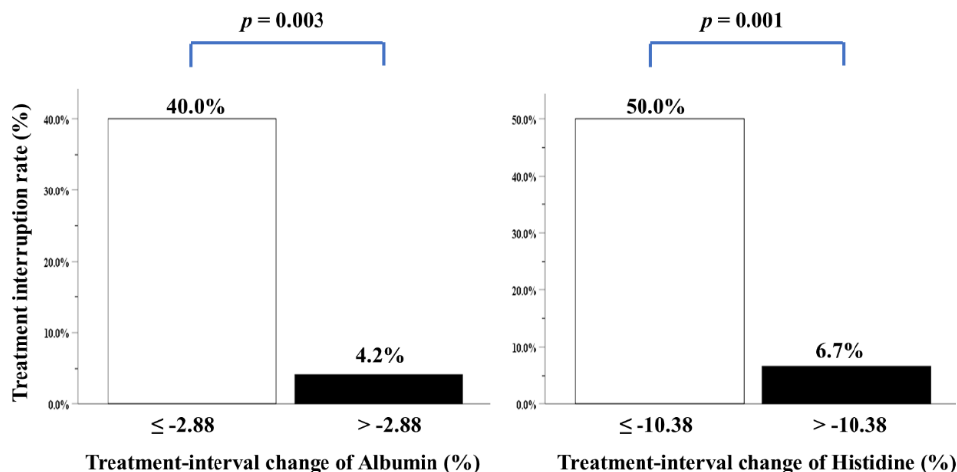
Figure 3. Treatment interruption rate of patients with LAHNSCC completing CCRT, stratified by treatment-interval changes in albumin or histidine levels. The cutoff value analyzed by ROC curves for treatment-interval changes in albumin levels was −2.88% (area under the curve (AUC): 0.762, p = 0.016), while that of treatment-interval changes in histidine levels was −10.38% (AUC: 0.768, p = 0.014). Table 4. Univariate and multivariate logistic regression analyses of risk factors associated with treat- ment interruption of 44 patients with LAHNSCC completing CCRT.